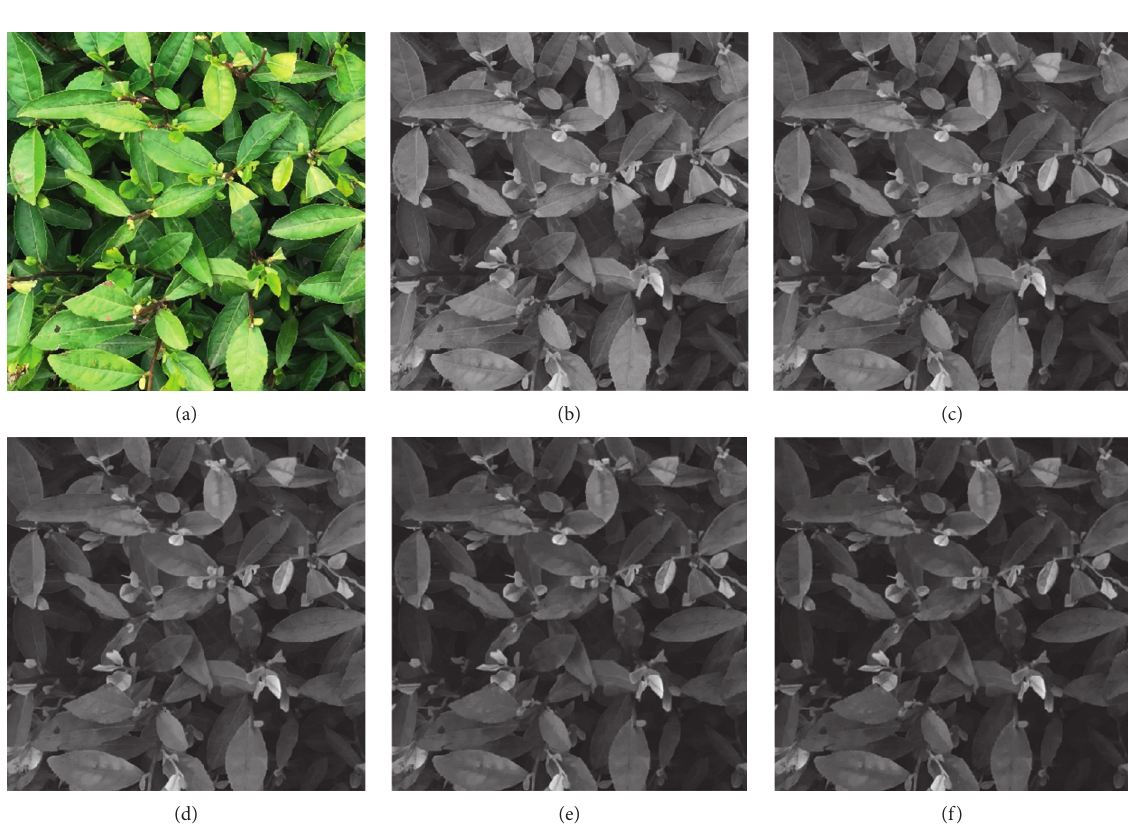
Figure 4: The image enhancement results by different weight coefficients ( α and β ); α is, respectively, 0.6, 0.7, 0.8, 0.9, and 0.95. (a) Color image, (b) enhanced image α � 0 . 6, β � 0 . 4, (c) enhanced image α � 0 . 7, β � 0 . 3, (d) enhanced image α � 0 . 8, β � 0 . 2, (e) enhanced image α � 0 . 9, β � 0 . 1, and (f) enhanced image α � 0 . 95. β � 0 . 05.